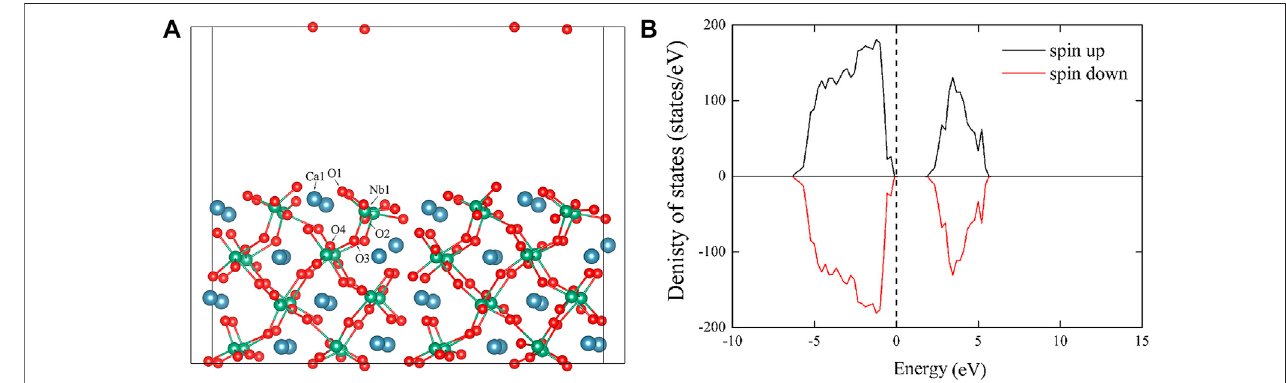
FIGURE 4 | Stable con fi guration of Ca 2 Nb 2 O 7 (010) surface with labeled Ca, Nb and O atoms to be removed for vacancy study (A) , and the total DOS of stoichiometric Ca